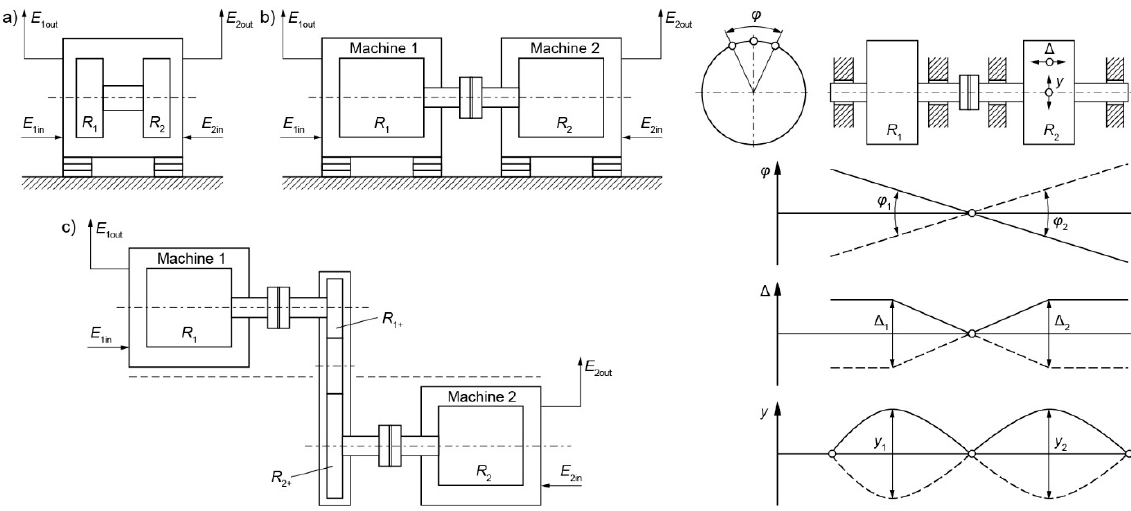
Figure 2. Rotors of the driving machine-driven machine set (on the left) and vibrations of the two- mass machine set rotor (on the right): ( a ) one rotor with one shaft, ( b ) one rotor with shafts connected by a coupling, ( c ) two rotors of a machine set with a transmission, E 1in —energy powering the driving machine, E 1out —energy carried away from the driving machine, E 2in —energy delivered to the driven machine, E 2out —energy at driven machine output, R 1 —rotor disc of the driving machine, R 2 —rotor disc of the driven machine, R 1+ , R 2+ —rotor discs of the transmission, φ —angular displacement of torsional vibration, Δ —displacement of axial vibrations, y —displacement of radial vibration.